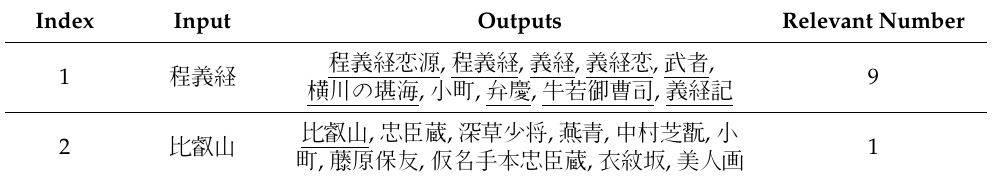
Table 3. Typical bad cases of M-CRBMs (s).